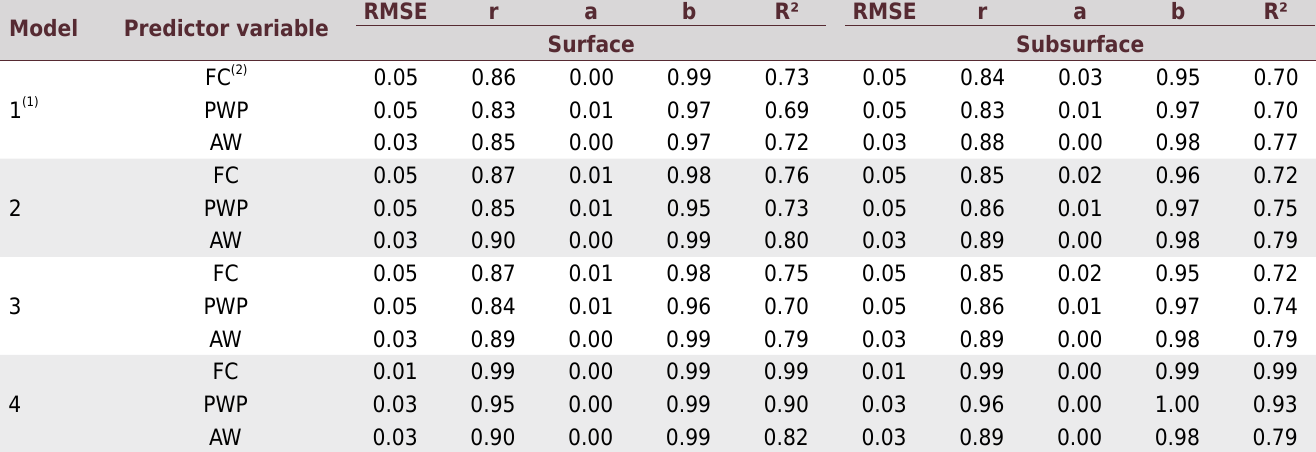
surface; Model 4 = clay, silt, organic carbon, and microporosity. (2) FC = field capacity; PWP = permanent wilting point; AW = available